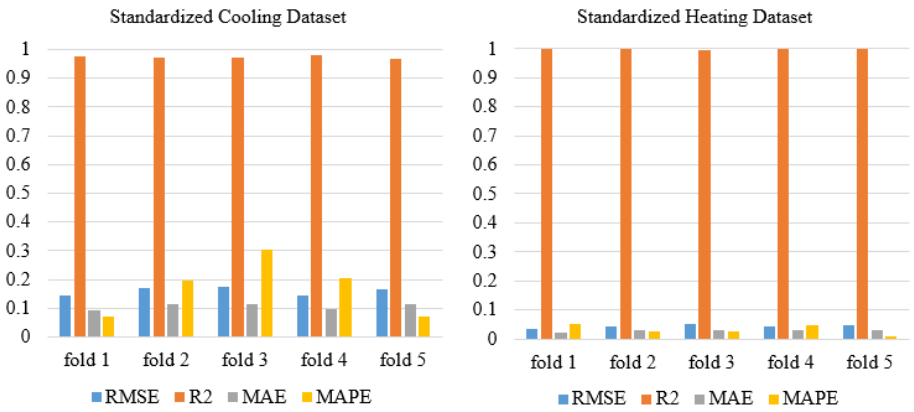
Figure 13. PTA Ensemble Detailed Evaluation Metrics Results Summary for the Best RMSE Values when Data Standardization is Applied.